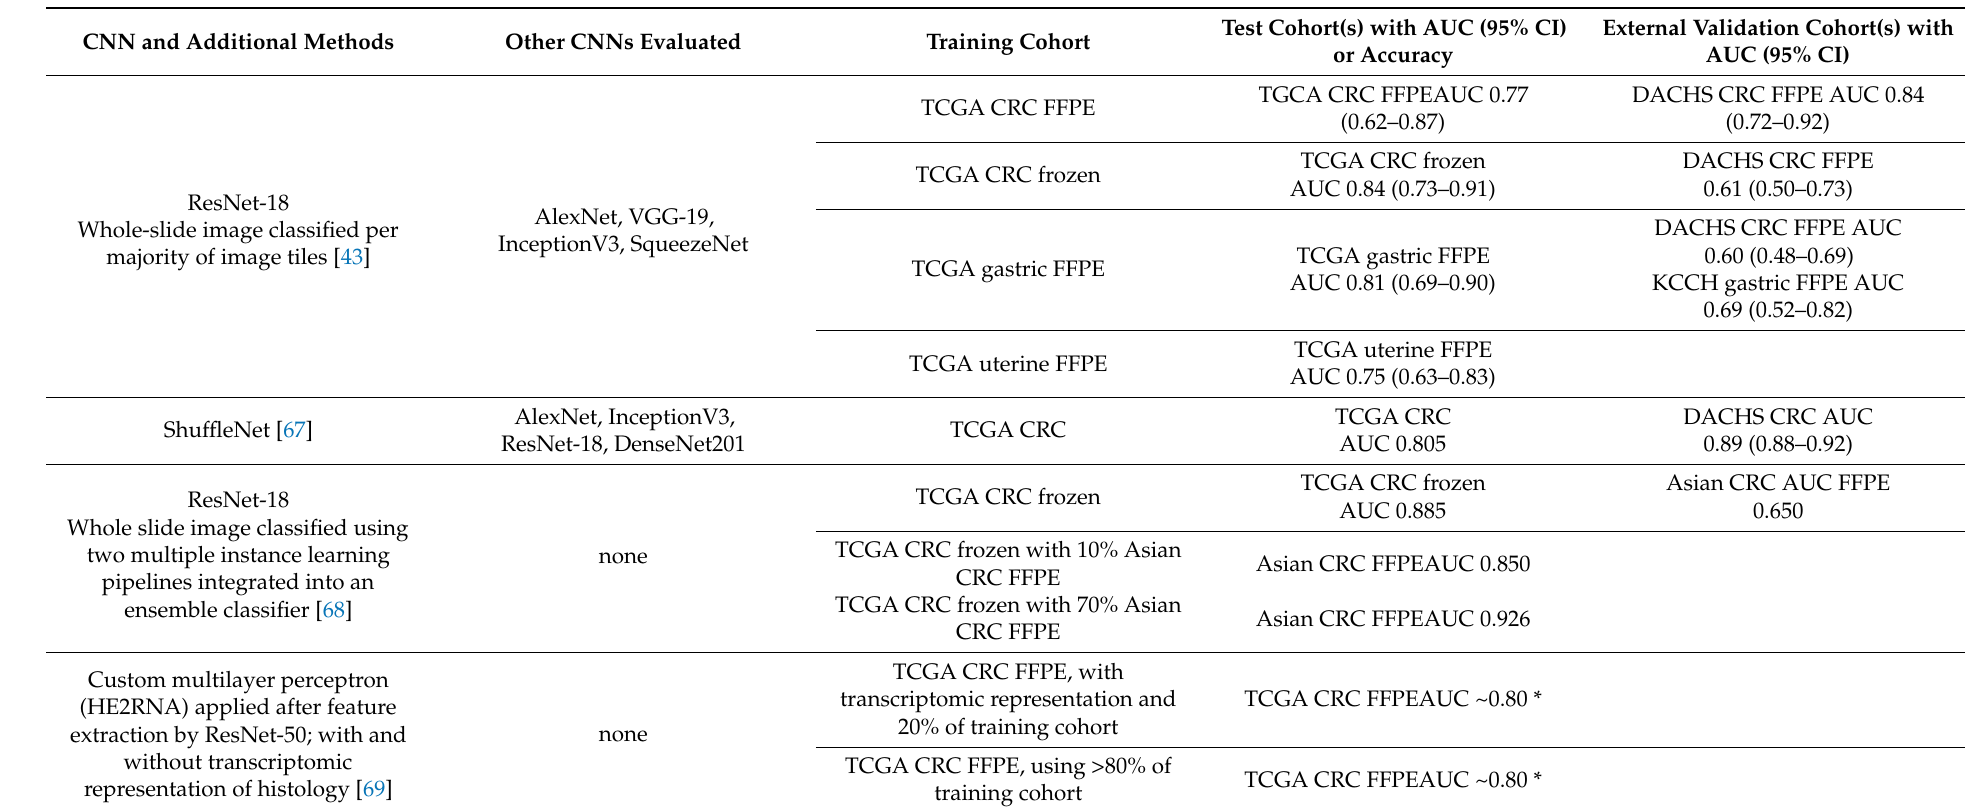
Table 2. Deep learning for prediction of MSI from digital